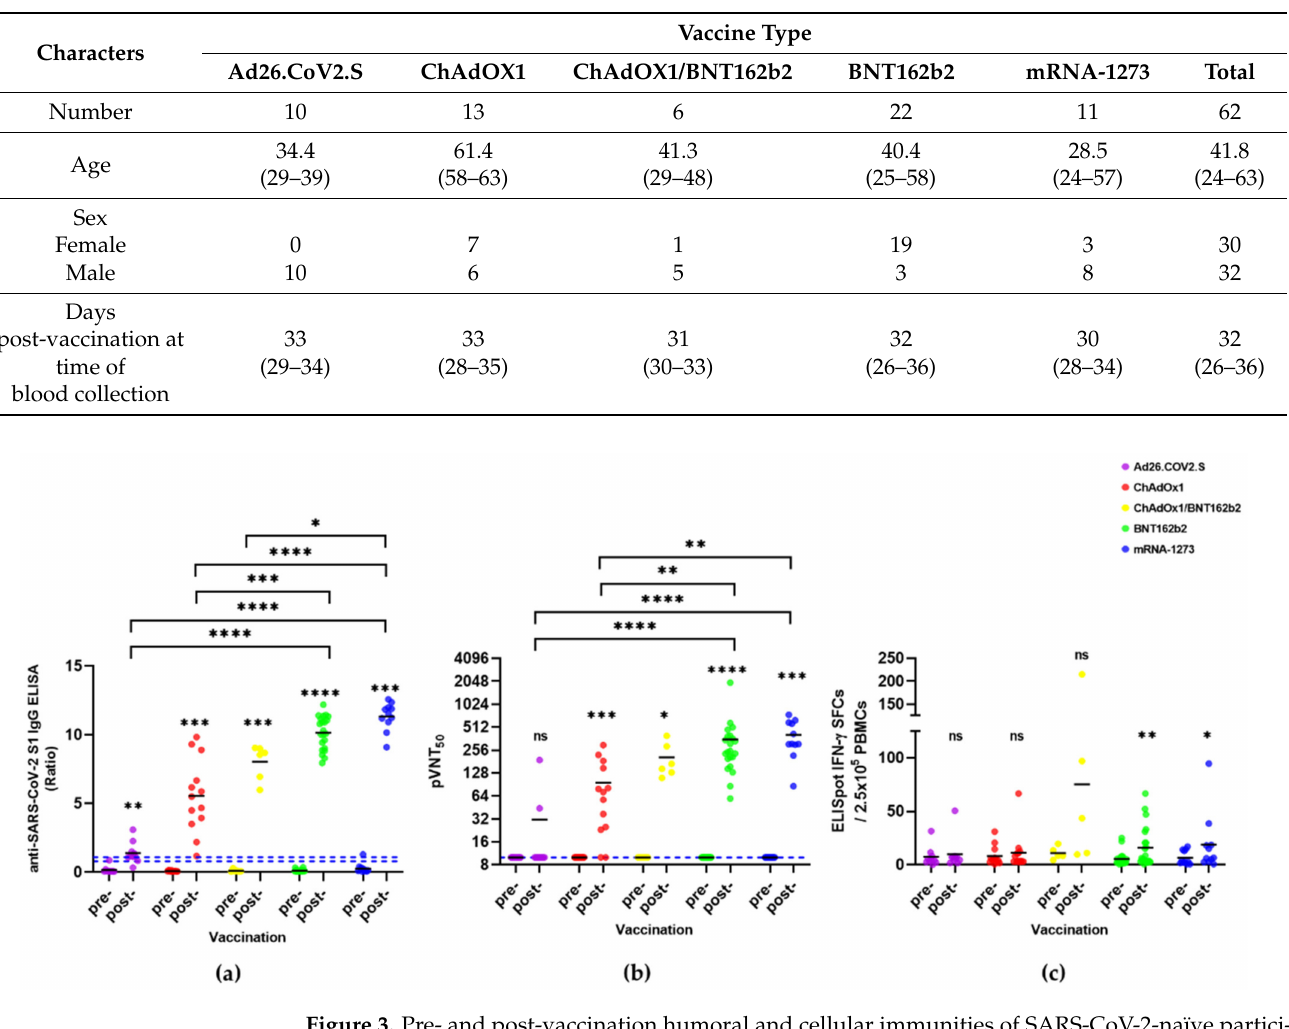
Table 4. Characteristics of SARS-CoV-2-naïve participants enrolled in the COVID-19 vaccine immuno- genicity study.